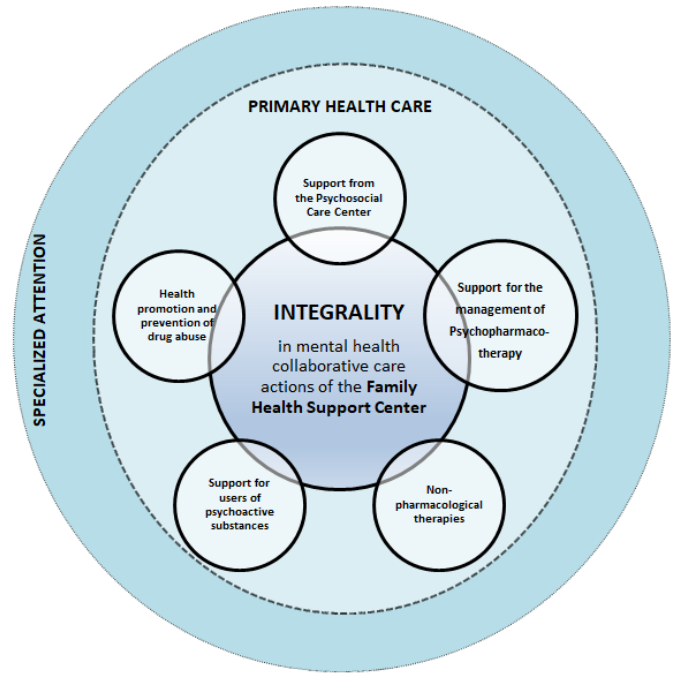
Figure 1. Theoretical model of mental health collaborative care of the Family Health Support Center, induced by the National Program for Improving Access and Quality of Primary Care in Brazil.